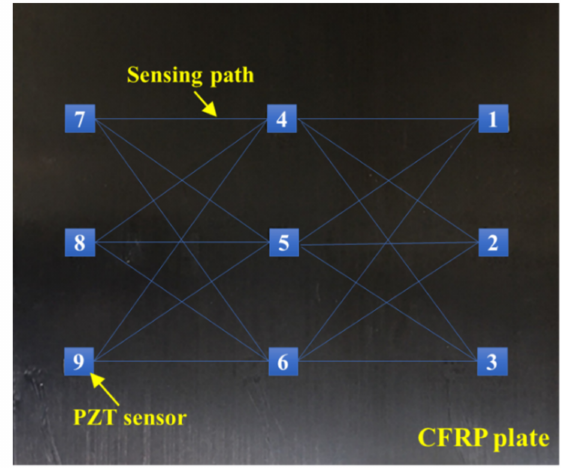
Figure 14. The sensing paths of the fabricated CFRP